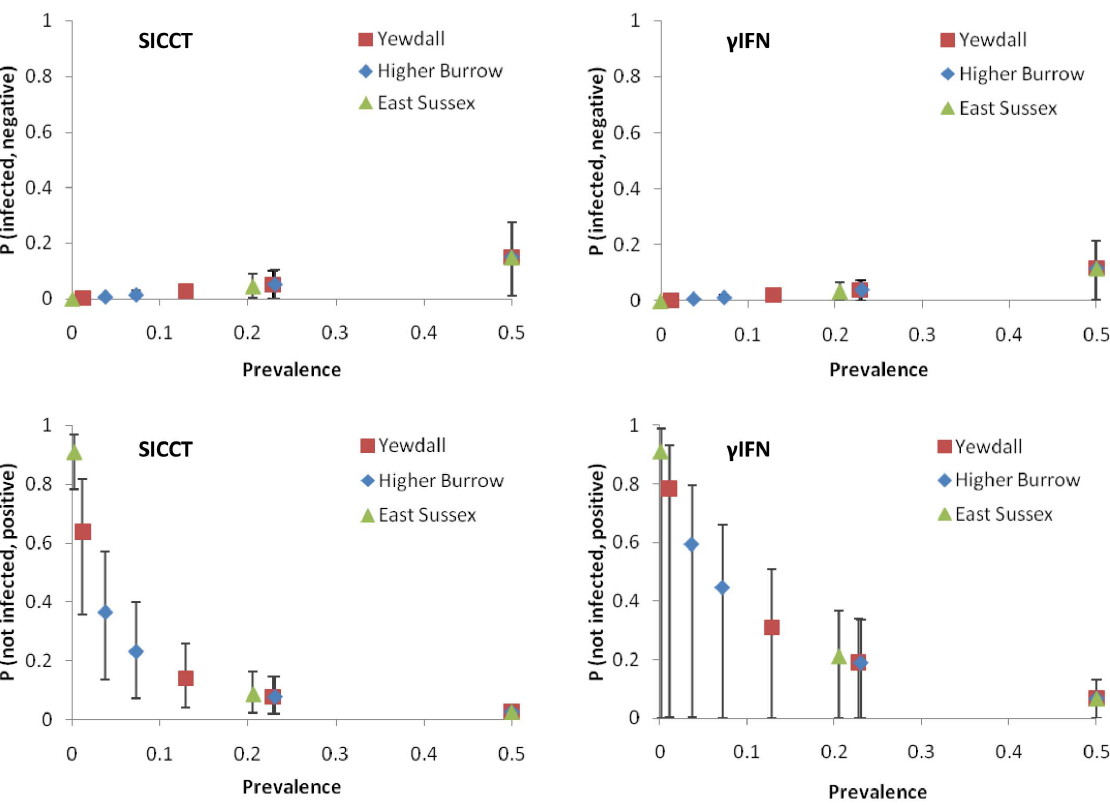
Figure 7. The probability of false BTB test outcomes in individual animals on three example farms. Using SICCT and c IFN tests, the mean probability of a randomly chosen animal which has tested negative to be infected (1-NPV; top figures) or an animal which has tested positive to be uninfected (1-PPV; bottom figures) is shown at various calculated TB prevalence levels. The herd prevalence levels were calculated from the actual test results at farms ‘Yewdall’, ‘Higher Burrow’ and ‘East Sussex’. Error bars represent 95% confidence limits.